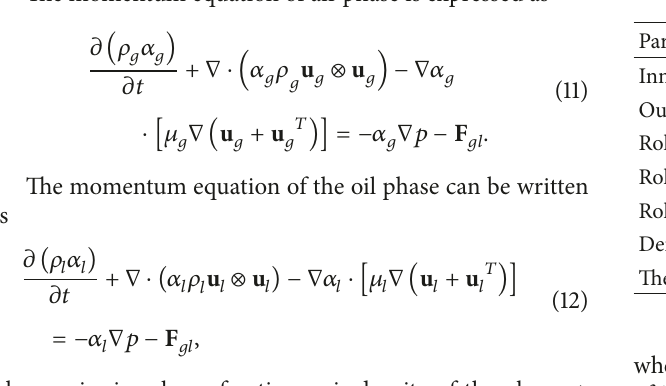
Table 1: Bearing